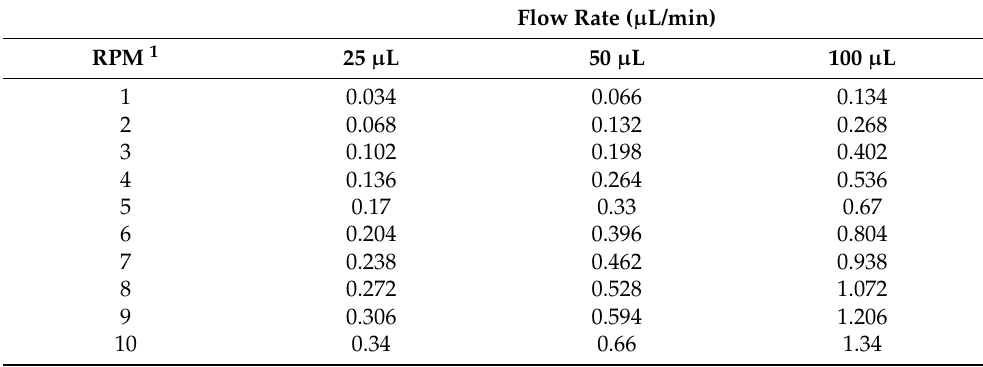
Table 1. The measured flow rates at various setting values of RPMs with three syringes.